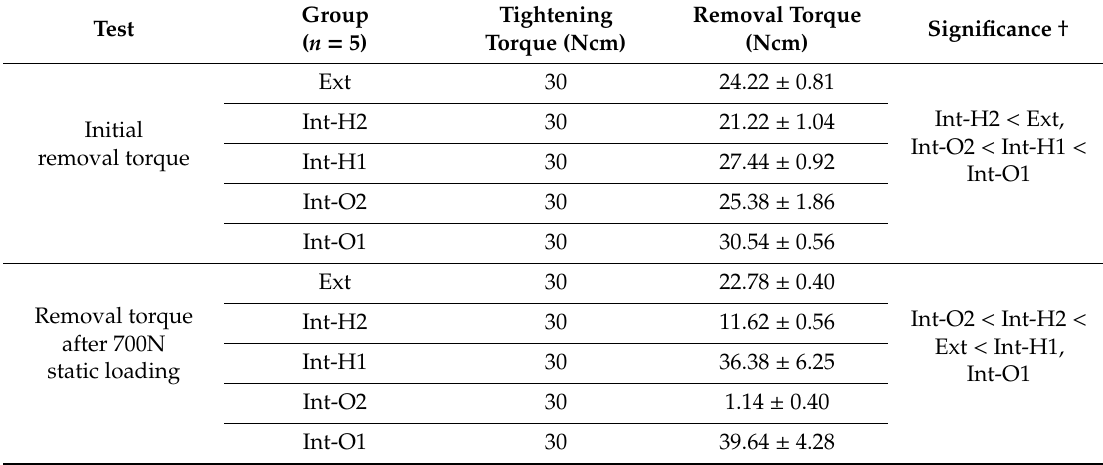
Table 4. Multiple comparisons of mean values of initial removal torque and removal torque after 700 N static loading.